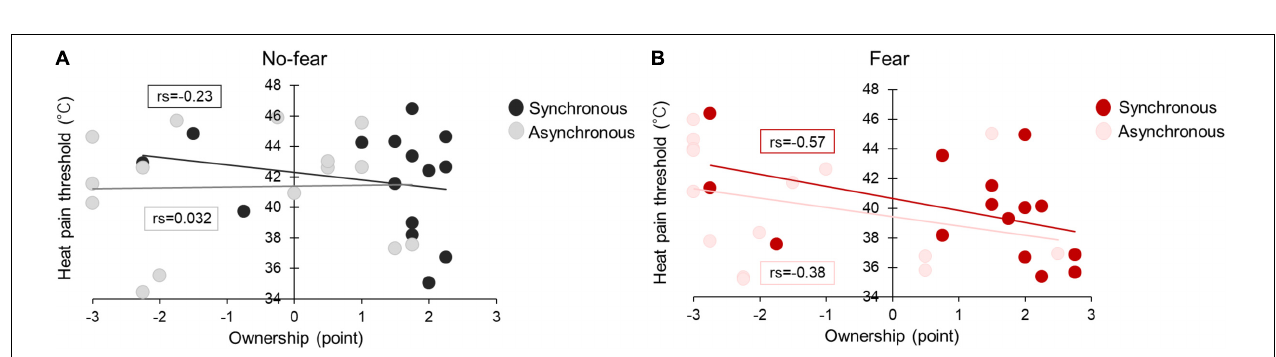
FIGURE 7 | Relationship between ownership of questionnaire and HPT in Experiment 2 (A,B)